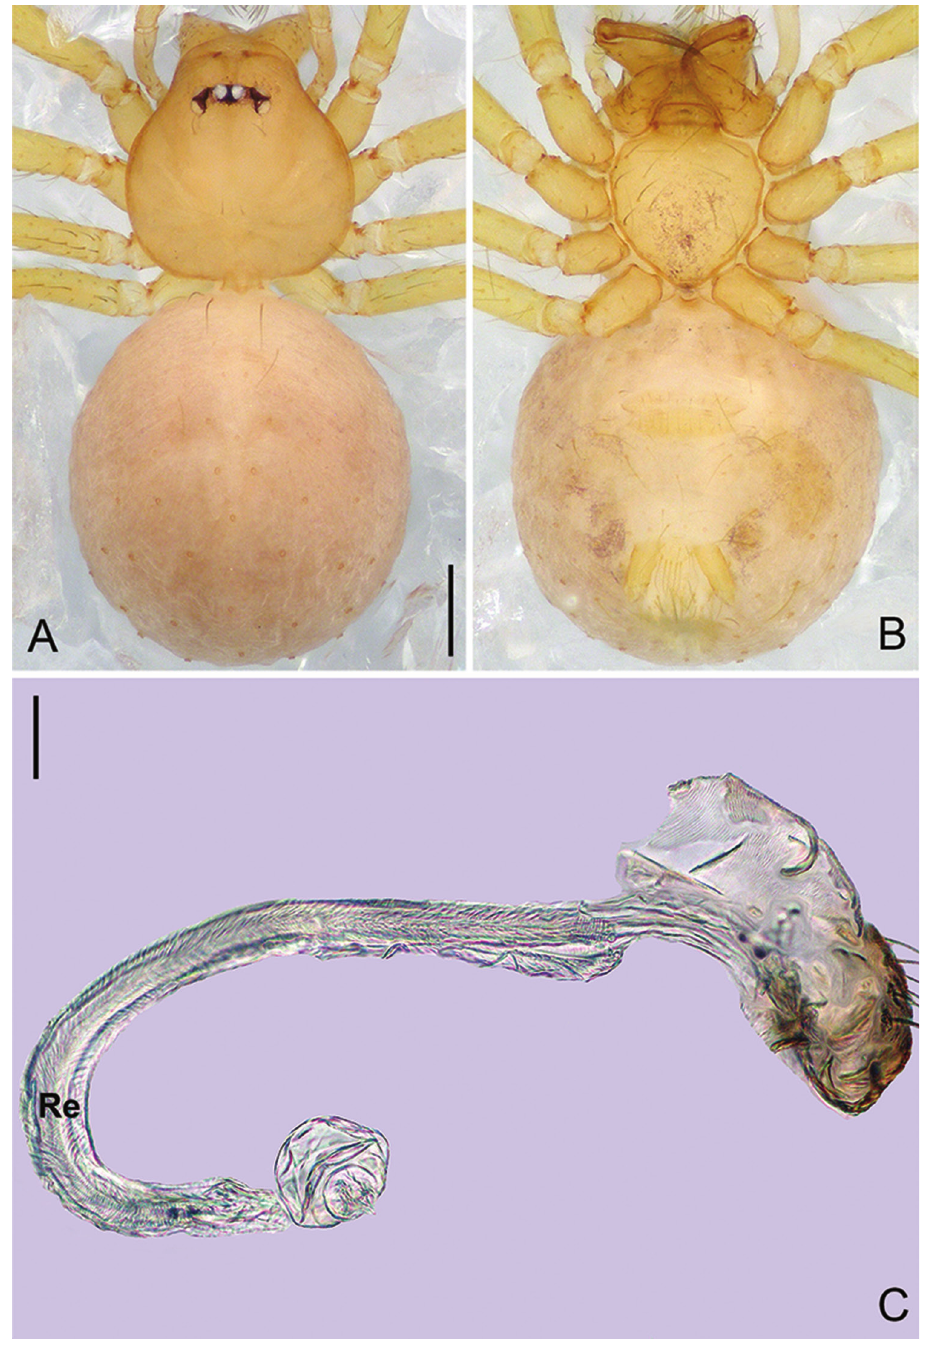
Figure 20. Pinelema wangshang Zhao & Li, sp. n., female paratype. A Habitus, dorsal view B Habitus, ventral view C Endogyne, lateral view. Scale bars: 0.2 mm ( A–B ), 0.05 mm ( C